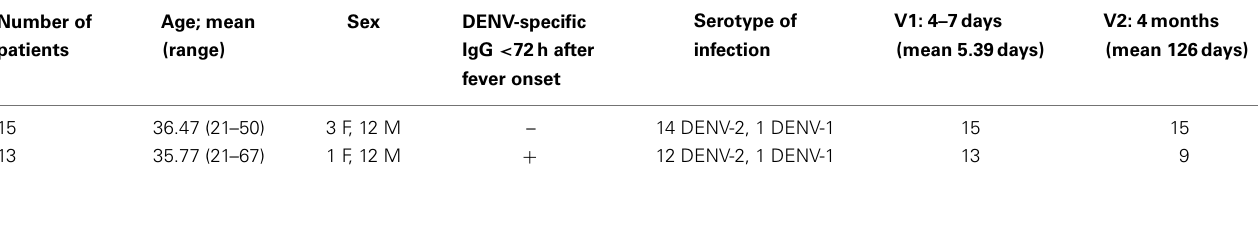
Table 2 | Cohort 2: cell phenotype analysis and PB correlations